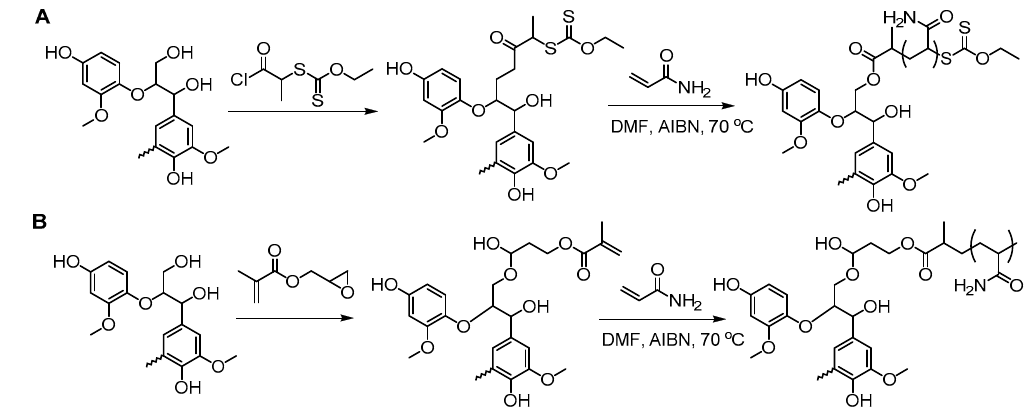
Figure 25. Synthesis of lignin– g –polyacrylamide via ( A ) RAFT and ( B ) FRP. Reproduced with permission [88].